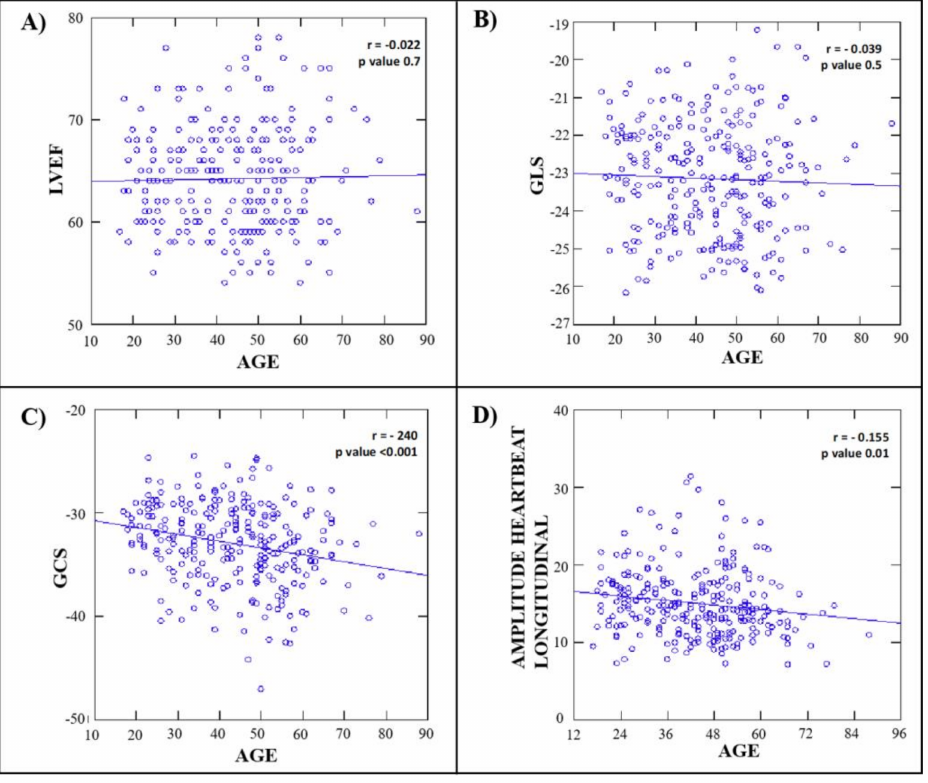
Figure 4. LVEF ( A ); GLS ( B ); GCS ( C ); amplitude heart beat longitudinal and ( D ) hemodynamic forces plotted against age in overall population. LVEF, left ventricular ejection fraction; GLS, global longitudinal strain; GCS, global circumferential